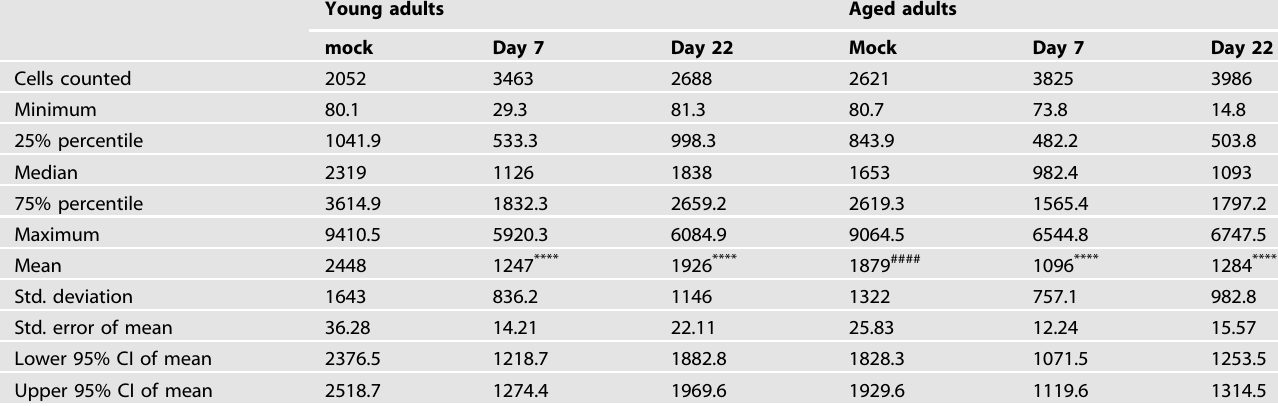
Table 1. Adipocyte size frequency distribution in SCAT.